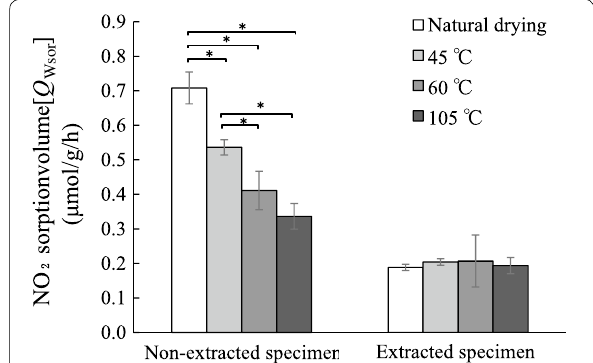
Fig. 6 NO 2 sorption volume per unit weight and time, Q w sor in non-extracted and extracted specimens under different drying conditions. The moisture content in the specimens was 9 The error bars show the standard deviation ( n